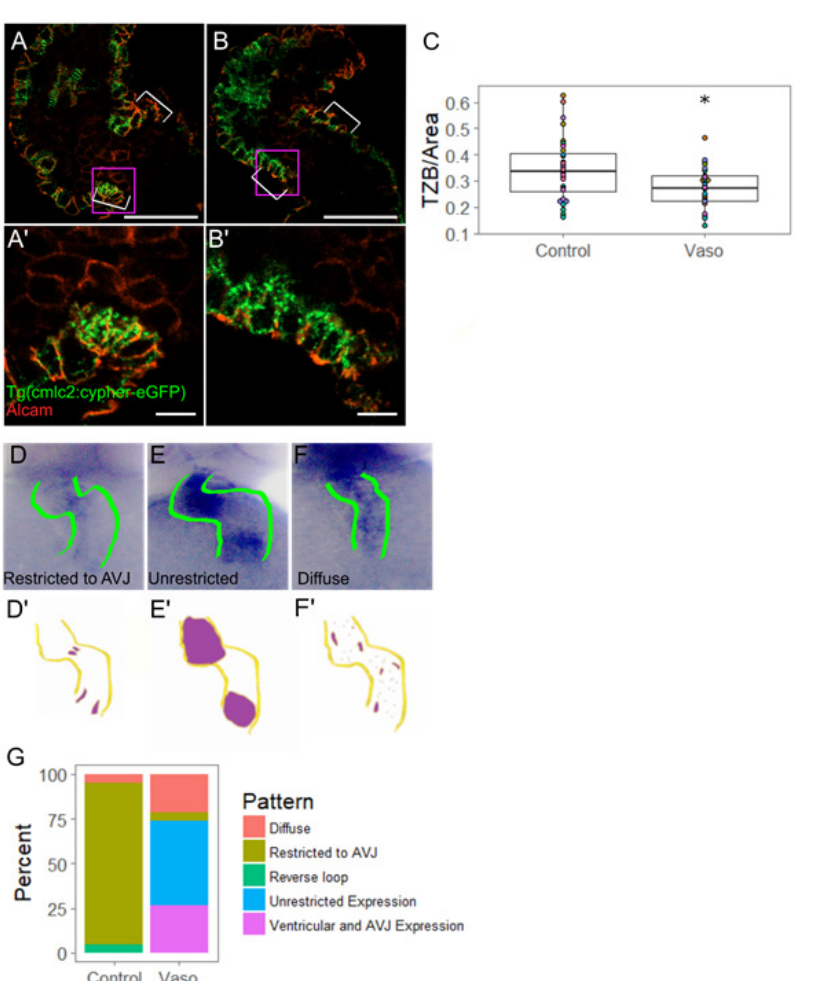
Figure 5. Increased pressure alters AVJ myocyte morphology and specification. ( A ) Control and ( B ) vaso-treated hearts showing z-disks and cell shape through ALCAM immunohistochemistry at 56 hpf. Purple box shows region of interest shown in ( A (cid:48) , B (cid:48) ). For ( A , B ), scale bar represents 20 µ m. ( A (cid:48) ) Control and ( B (cid:48) ) vaso-treated hearts. Scale bar represents 10 µ m. White arrow heads indicate AVJ. ( C ) TZB of sarcomeres present in each cell normalized to the area of each cell (1/ µ m). n = 36 cells for control and 33 for vaso-treated hearts. ( D ) In situ hybridization (ISH) of myocardial AVJ marker bmp4 in control and ( E , F ) vaso-treated hearts. ( D (cid:48) – F (cid:48) ) Diagrams of ISH expression patterns. ( G ) Percent of fish expressing a particular bmp4 expression pattern. A total of 20 fish were scored in each group. * indicates p < 0.05.